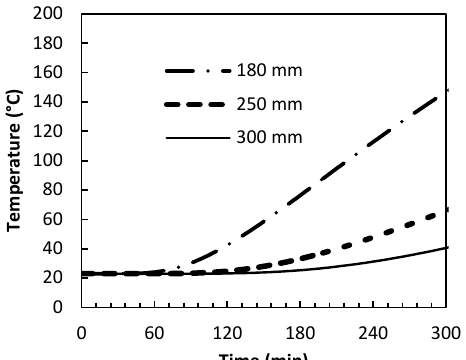
Figure 3. Temperatures at unexposed surface of